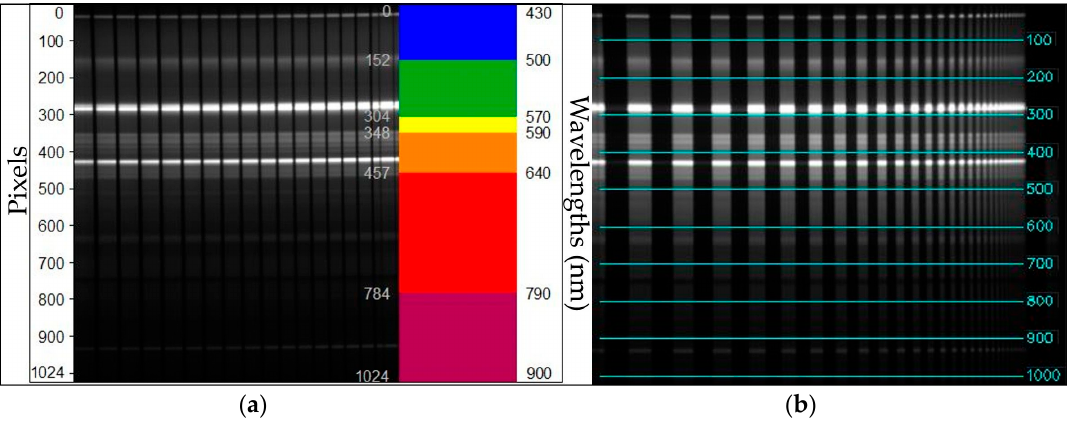
Figure 8. ( a ) Distribution of wavelengths in the raw HSLS V9 image along axis y. ( b ) Positions of the spectral lines for which MTF was calculated (blue transverse lines, while the numbers indicate the ordinal number of the line in relation to the initial line, in pixels).